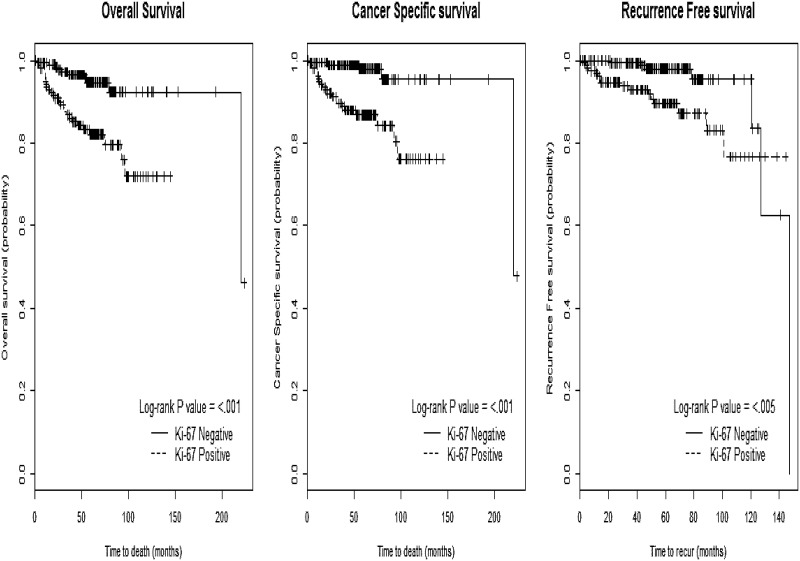
The Kaplan-Meier curves of Ki-67 according to (A) overall survival, (B) cancer-specific survival, and (C) recurrence-free survival.